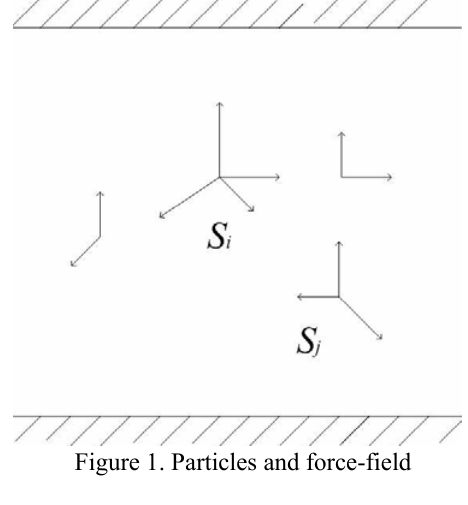
Figure 1. Particles and